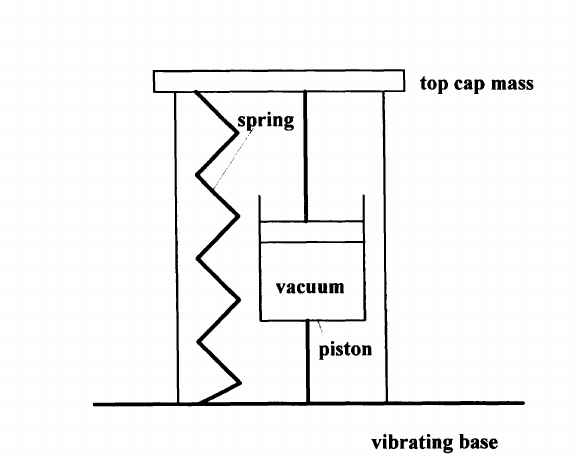
FIGURE 5 Spring and piston analogue for a bed of cohesive